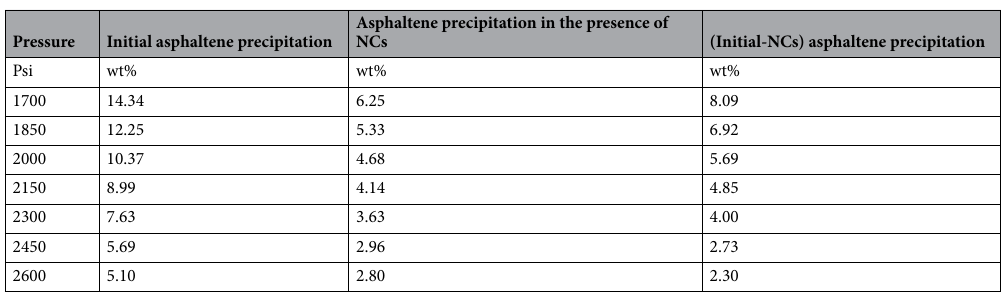
Table 7. Difference between Initial asphaltene precipitation and asphaltene precipitation in the presence of